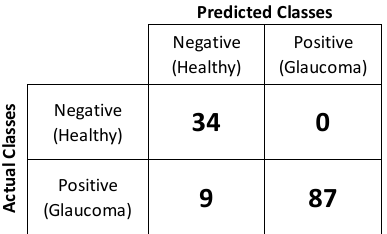
Figure 13. Confusion matrix of DenseNet performance.